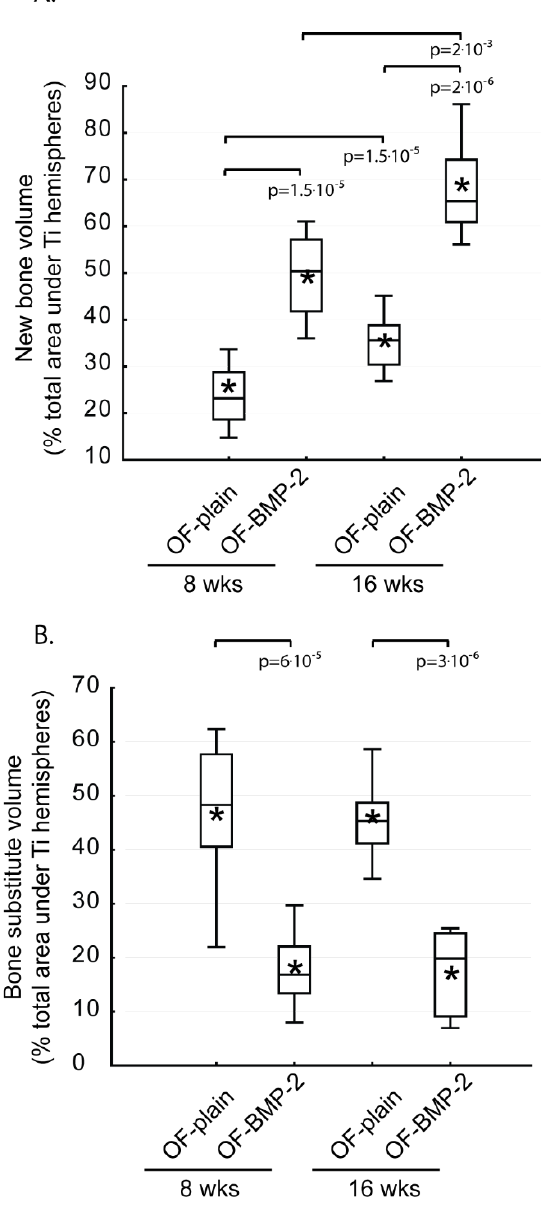
Figure 5. Histomorphometrical assessment of new bone volume ( A ) and volume of bone substitute ( B ) under the hemispheres at 8 and 16 weeks ( n = 8 for each column). Brackets and p values indicate significant differences. Horizontal line: median. Boxes: 25%–75%. * : mean. Bars: range of non-outliers. (OF-plain: bare construct; OF-BMP-2: BMP-2 primed